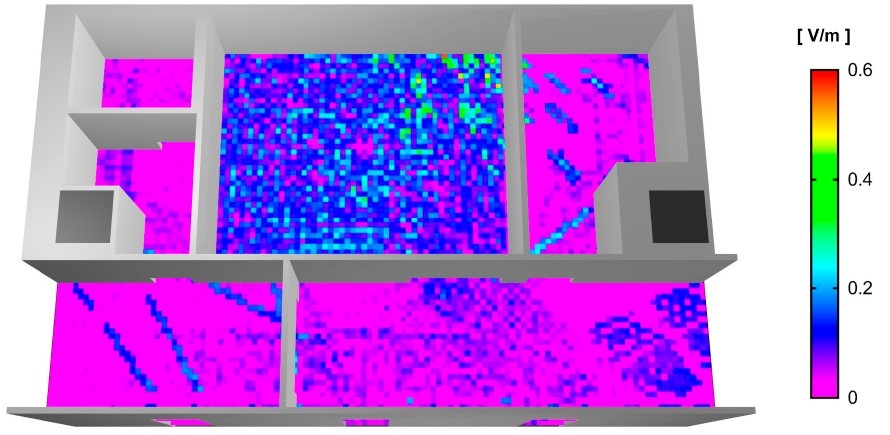
Figure 11. E-field distribution within the hospital ward simulation scenario [13].